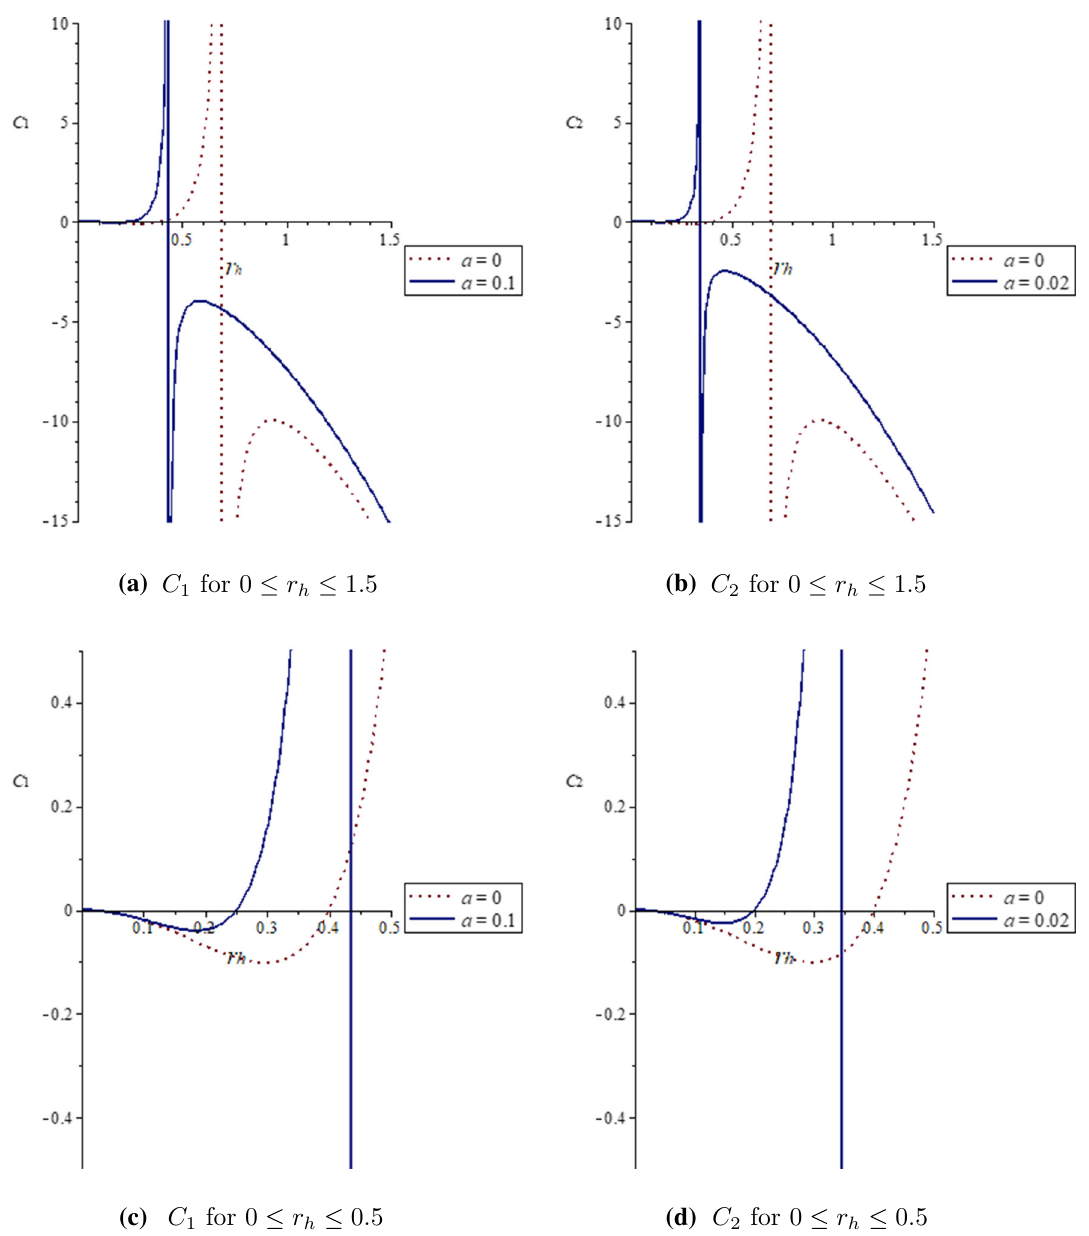
Fig. 2 The heat capacity versus the event horizon radius with q = 0 . 4, the dotted curve corresponds to the Reissner–Nordstrom case and the solid curve to the non-minimal